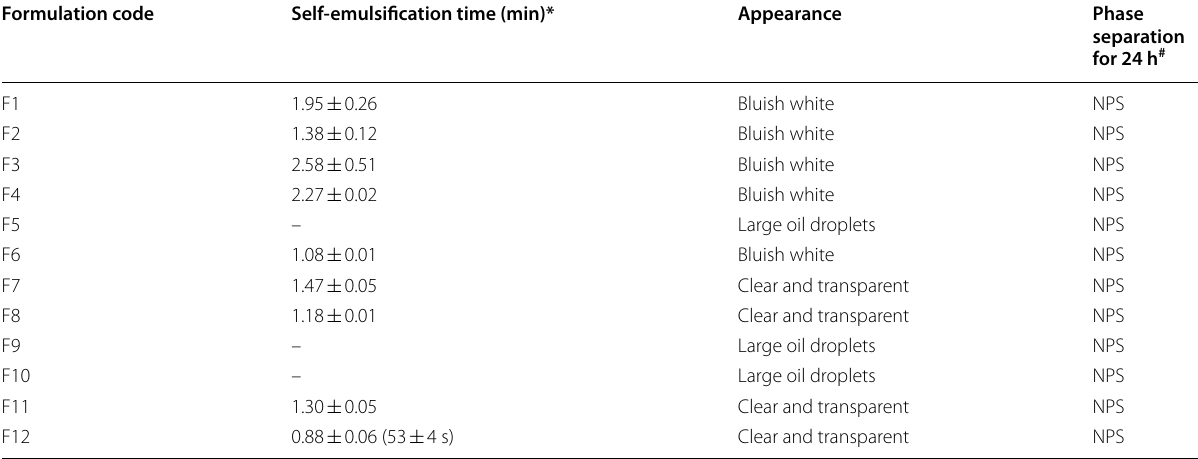
Each value represents the mean *Self-emulsification time (s) # NPS no phase separation